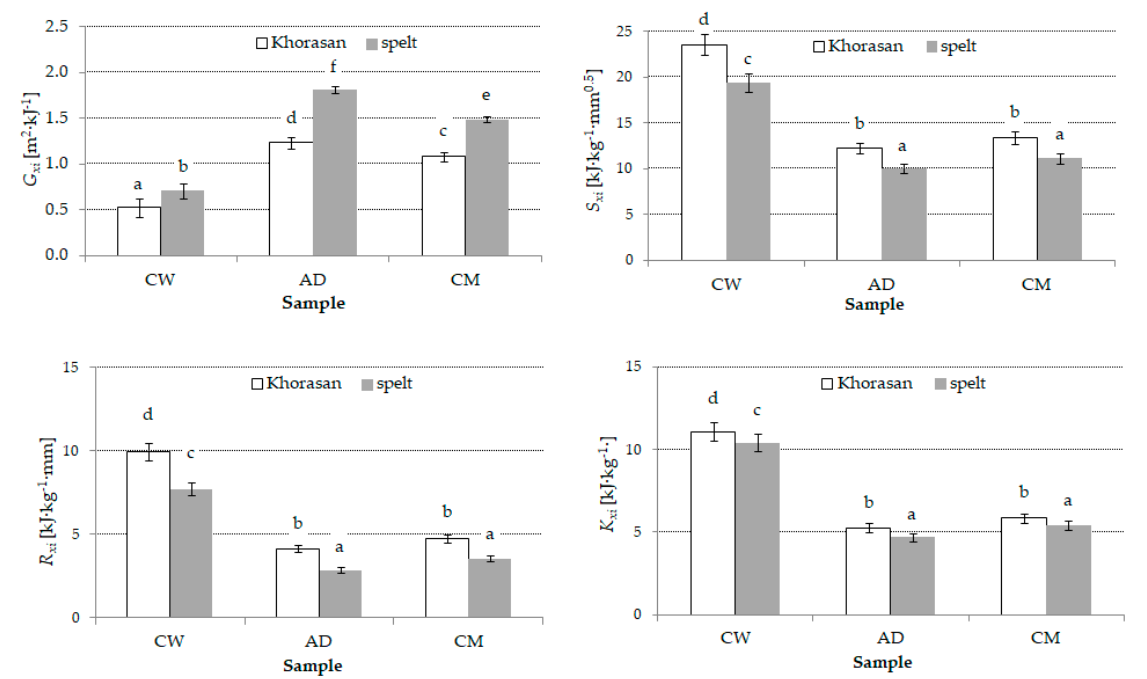
Figure 2. Grinding energy indices of the control wheat (CW) and dried wheat (AD = air-dried wheat, CM = wheat stored in the climatic chamber). G xi = grinding ability index, S xi = Sokołowski’s grinding index, R xi = Rittinger’s grinding index and K xi = Kick’s grinding index. The values in columns designated with different letters are statistically significantly different ( p < 0.05).